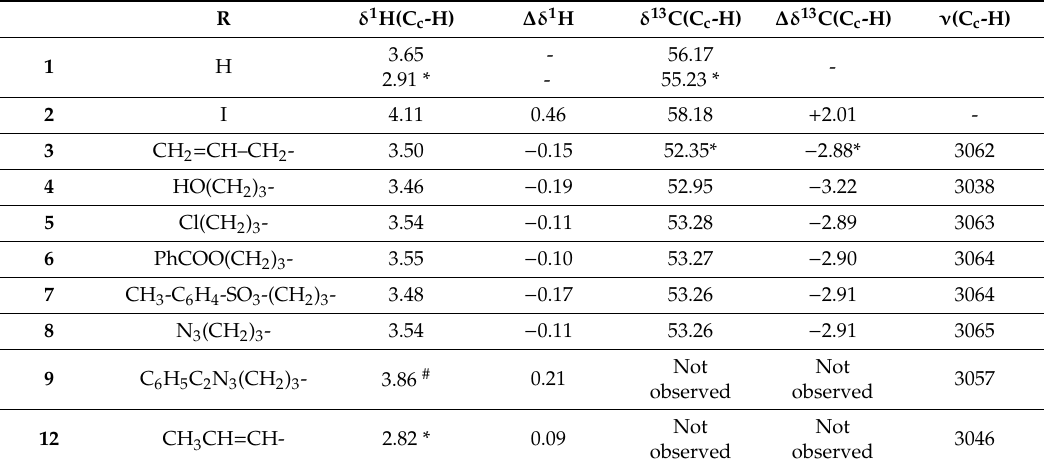
Table 4. Chemical shift of 1 H and 13 C{ 1 H} NMR spectra (in ppm) and stretching frequencies of C c -H (in cm − 1 ) in the IR spectra for the 9,10-R 2 -1,7- closo- C 2 B 10 H 10 derivatives. NMR spectra were run in (CD 3 ) 2 CO unless noted otherwise: * CDCl 3 and # (CD 3 ) 2 SO.